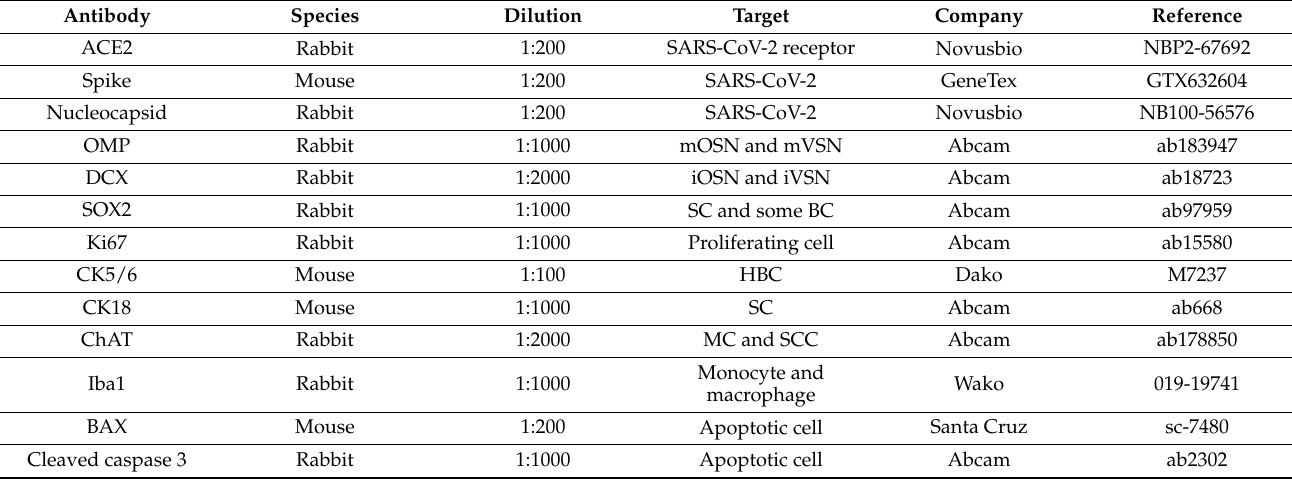
Table 1. Primary antibodies used in this